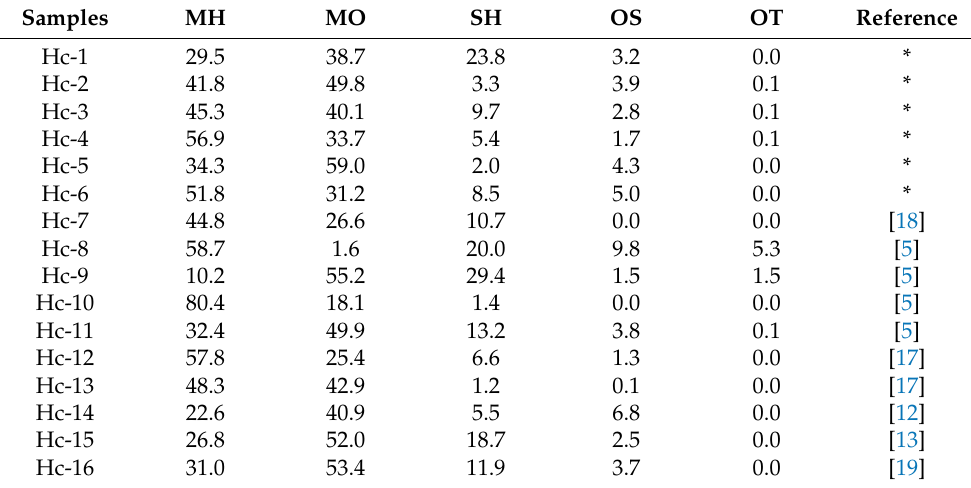
Table A2. Compound classes used in the multivariate statistical analyses of Hyptis crenata oils samples.